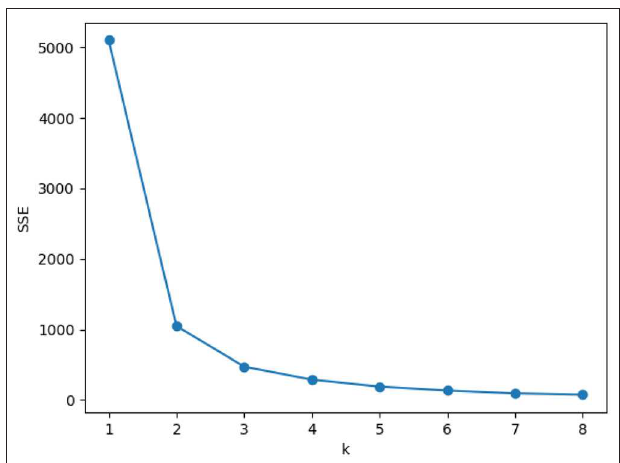
FIGURE 1 | SSE and k relationship diagram. SSE decreases with the increasing number of k . The optimal k is where the SSE decreases the most drastically. In this diagram, the optimal k can be 2 or 3. According to our study, we choose 2 as the optimal k .